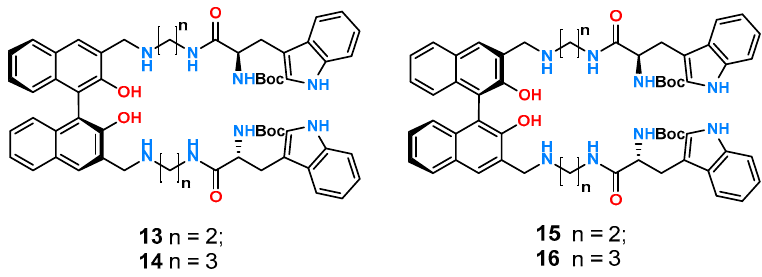
Figure 7. Receptors 13 – 16 based on BINOL decorated with tryptophane.